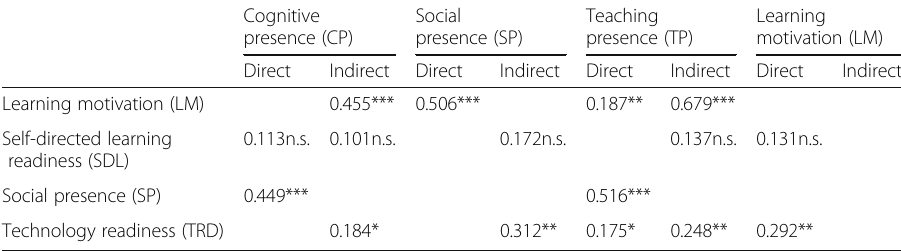
Table 8 Structural path coefficients for NBL group